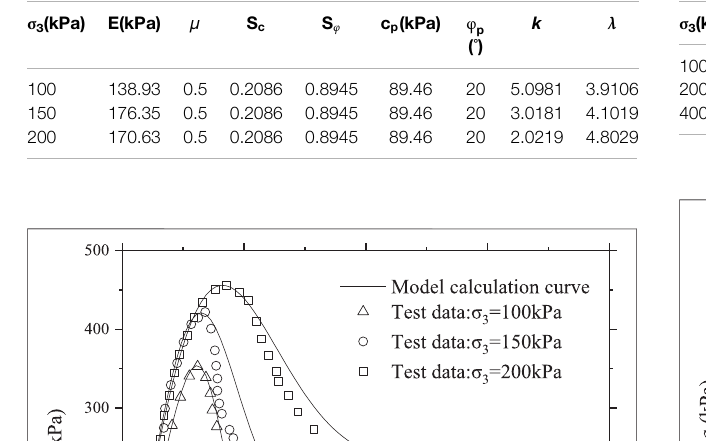
TABLE 2 | Model parameters of data in this paper.